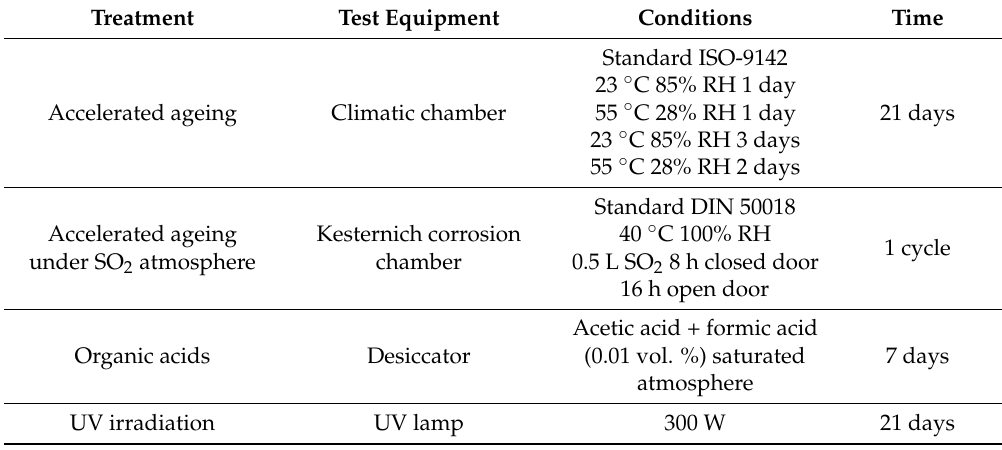
Table 5. Experimental details of the weathering and chemical treatments carried out.